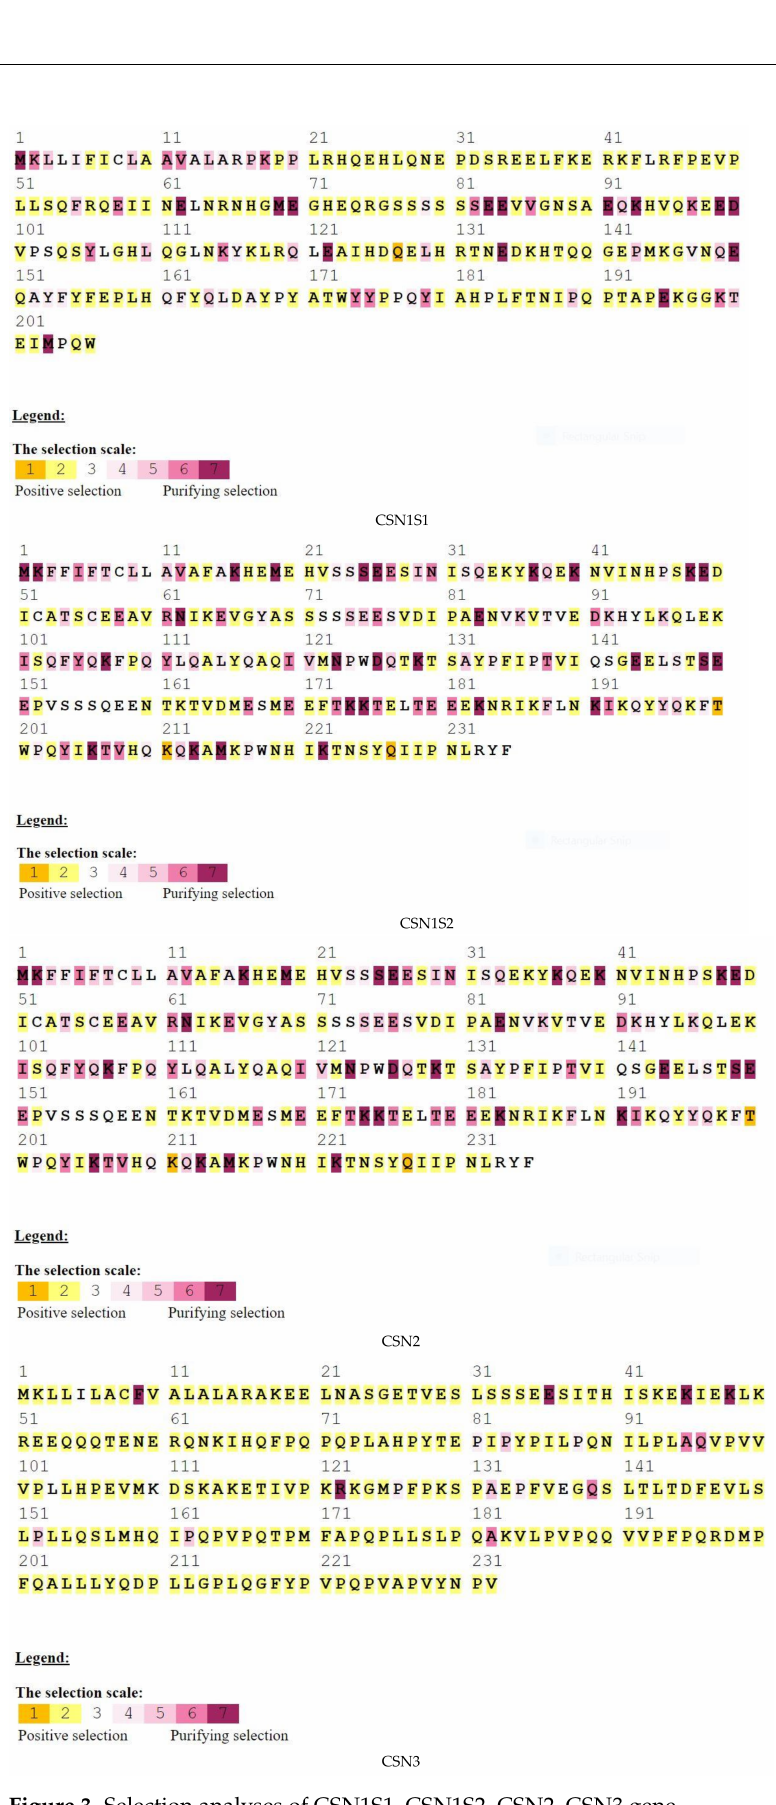
Figure 3. Selection analyses of CSN1S1, CSN1S2, CSN2, CSN3